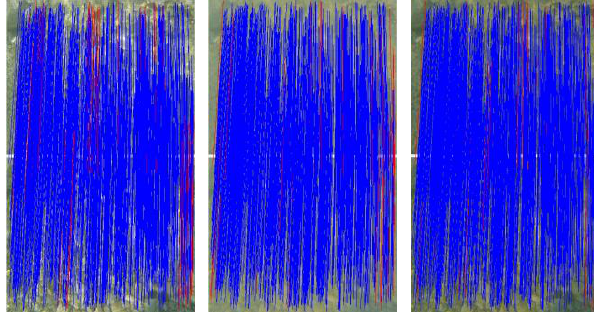
Figure 5. The matched points of an image pair from dataset 1 in Agisoft’s Photoscan